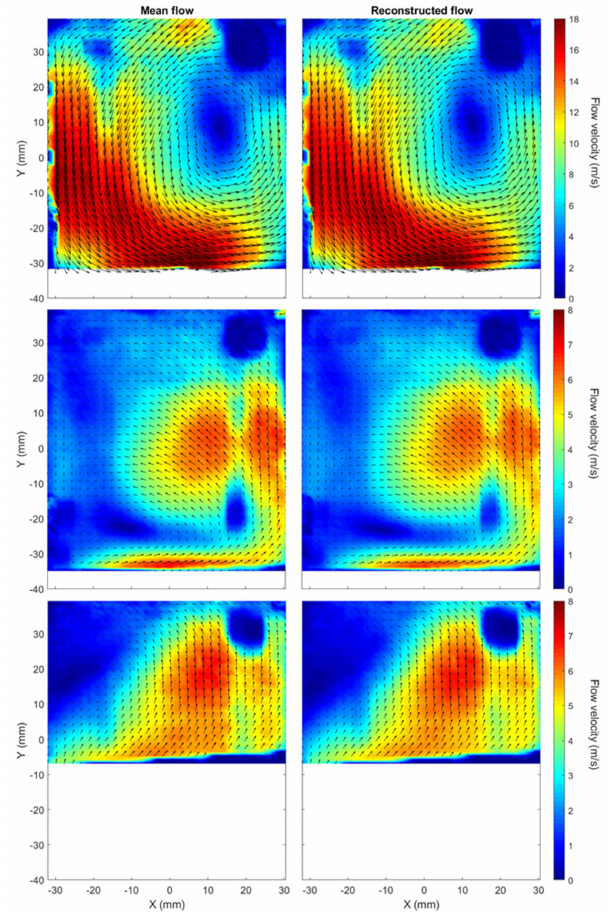
Figure 10. Mean field and reconstructed field with 6 modes; θ = 130, 220 and 270 ◦ CA (from top to bottom); θ VVT = 30 ◦